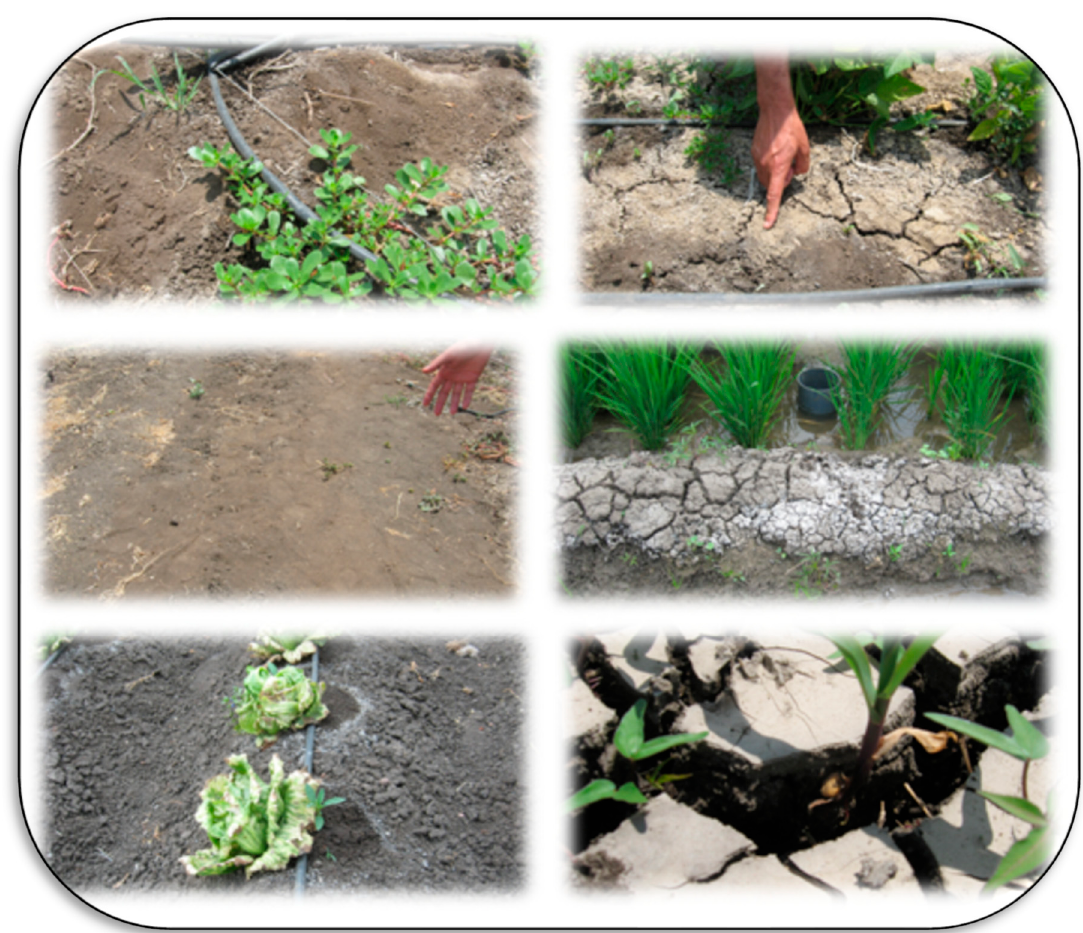
Figure 6. Some common features of saline-alkaline soils at the experimental farm of Kafrelsheikh Uni. (Egypt), which represent in sabkha on the soil surface and growing the purslane plants (the first higher 2 photos beside the middle photo left ), the accumulation of salts during rice growing in saline soil in the middle photo right , and the lower photos ( left ) general view to saline soil during cultivating lettuce under drip irrigation and deep cracks due to heavy clay content (the lower right photo). Photos by El-Ramady.